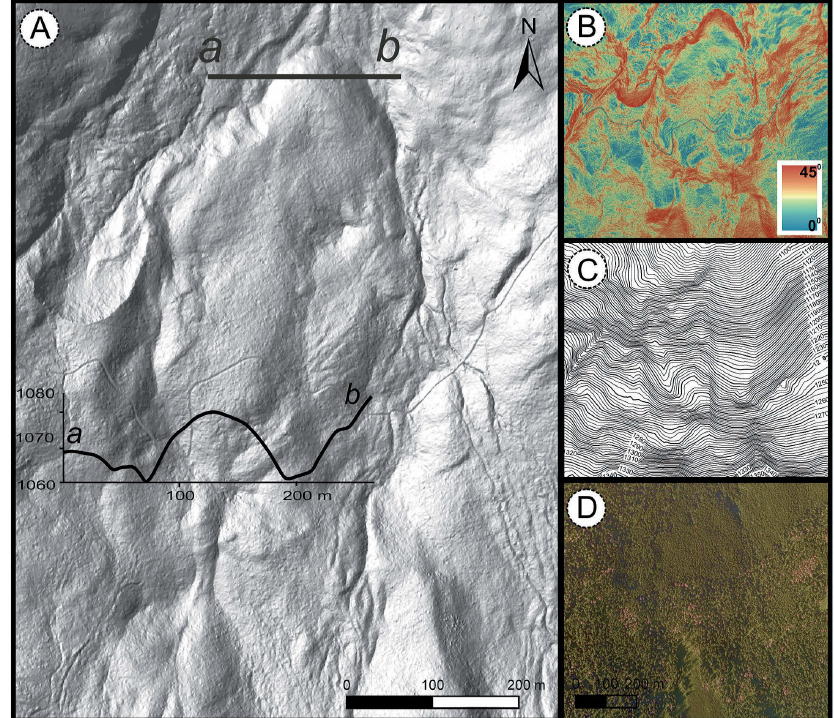
Fig. 9. Test area No 8. A – LiDAR image (a–b – topographic profile and its location), B – the map of slope reductions generat- ed from LiDAR (range of slope reductions is given), C – contour-line map, D – orthophotomap. Maps B–D at the same scale, Map A at larger